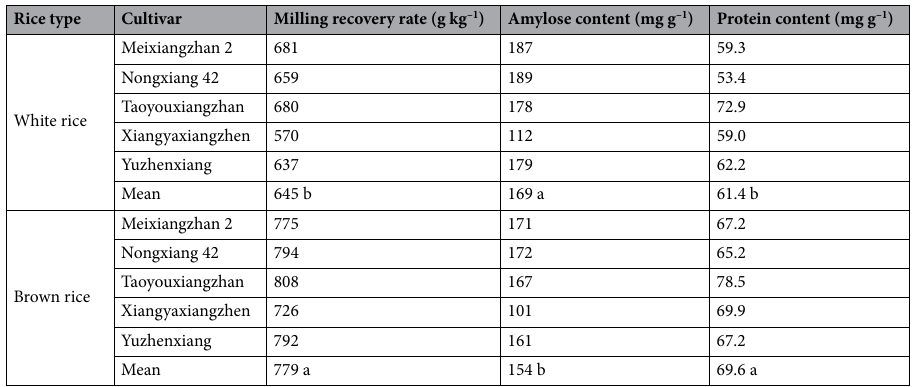
Table 1. Milling recovery rate and amylose and protein content of white and brown rice of five cultivars. Means within a column sharing different letters are significantly different from each other at the 0.05 probability level.